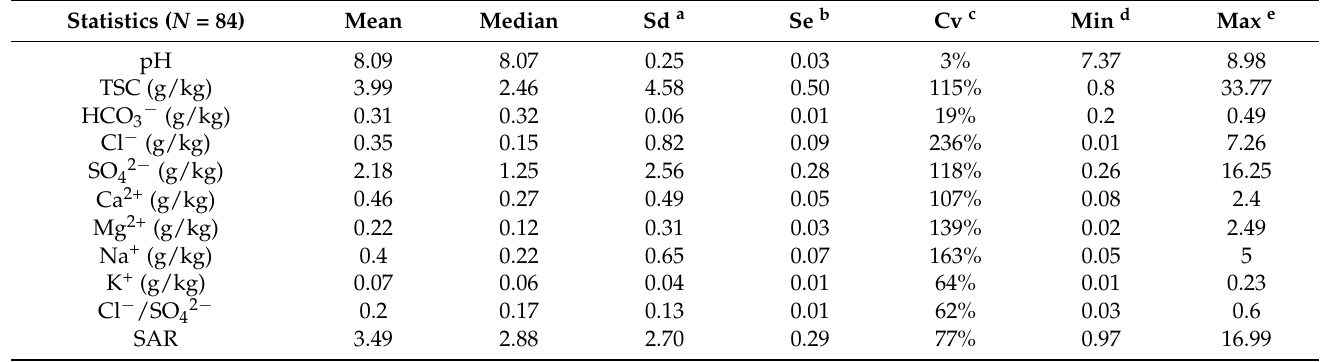
Table 3. Statistical parameters of major ions, total salt concentration (TSC), pH, Cl − /SO 42 − , and SAR.